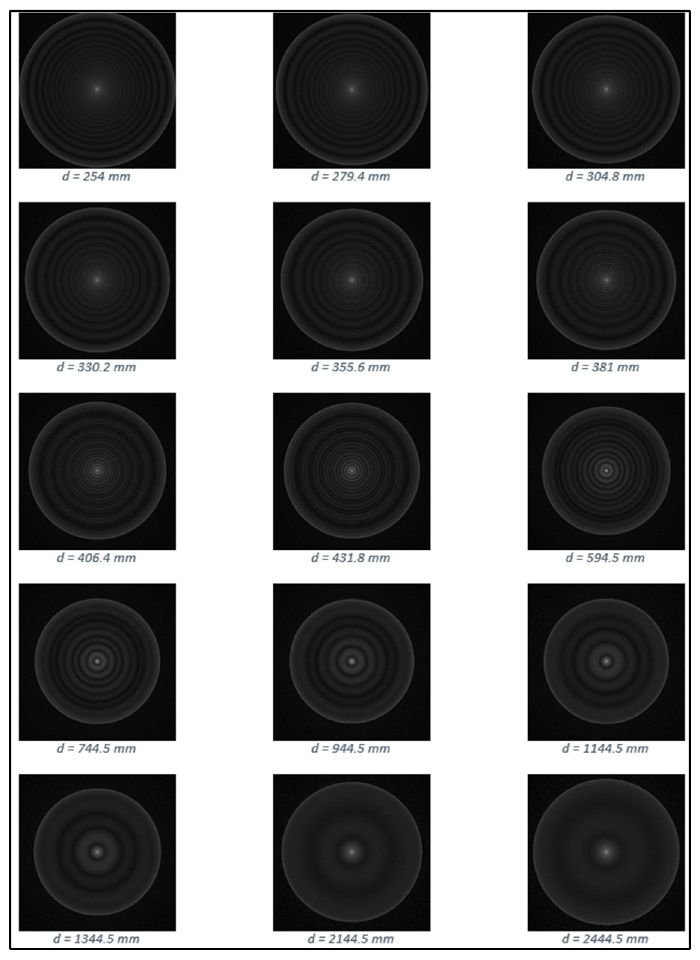
Figure 19. Some backscattered simulated images at different distances to the sphere. Contrast enhancement is used to enhance the signal.